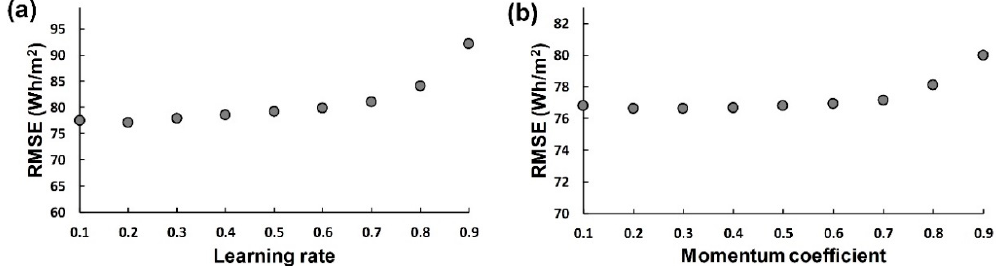
Figure 5. Calibration of hyperparameters: ( a ) Learning rate; ( b ) Momentum coefficient.